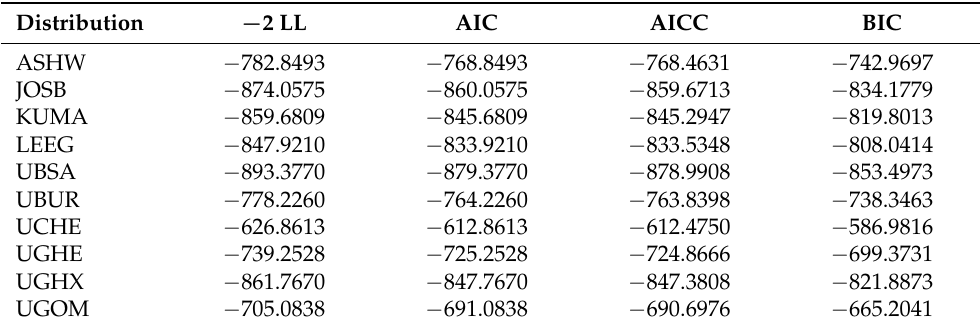
Table 19. Values of the indicated likelihood-based statistic and distribution for τ = 0.25 with data related to fat percentage at the